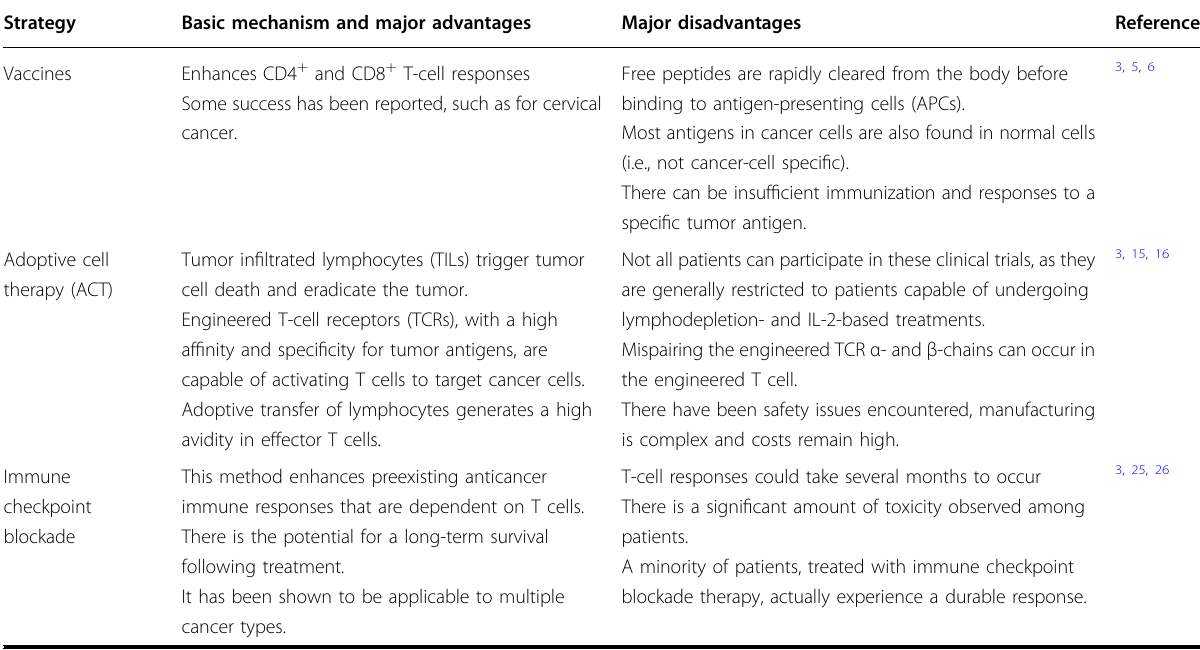
Table 1 Categories of cancer immunotherapies